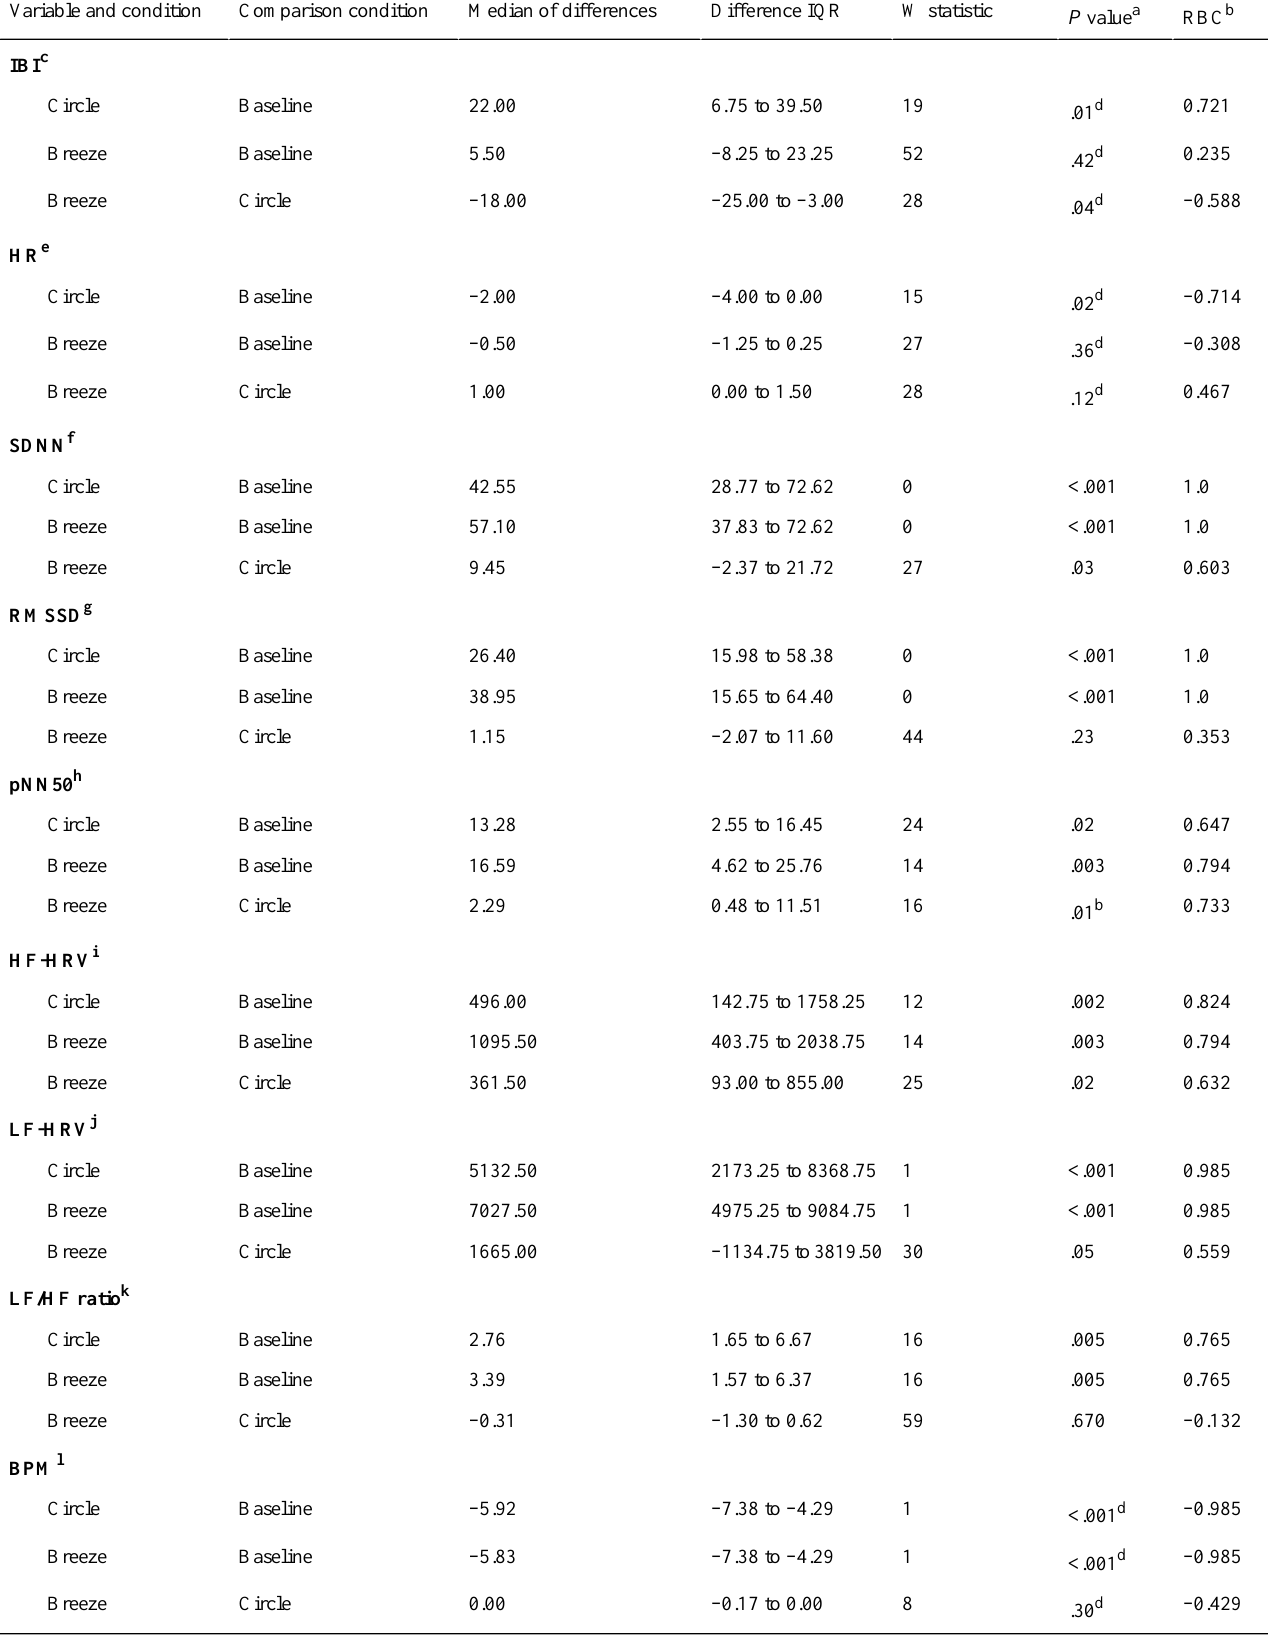
Table 3. Pairwise comparisons between baseline, Circle, and Breeze using the Wilcoxon signed-rank